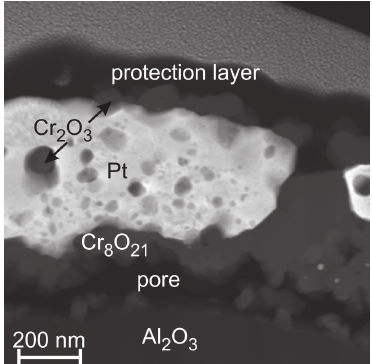
Figure 11. STEM image (chemical contrast) of the Pt ∗ film on Cr seed layer after annealing at 1000 ◦ C in